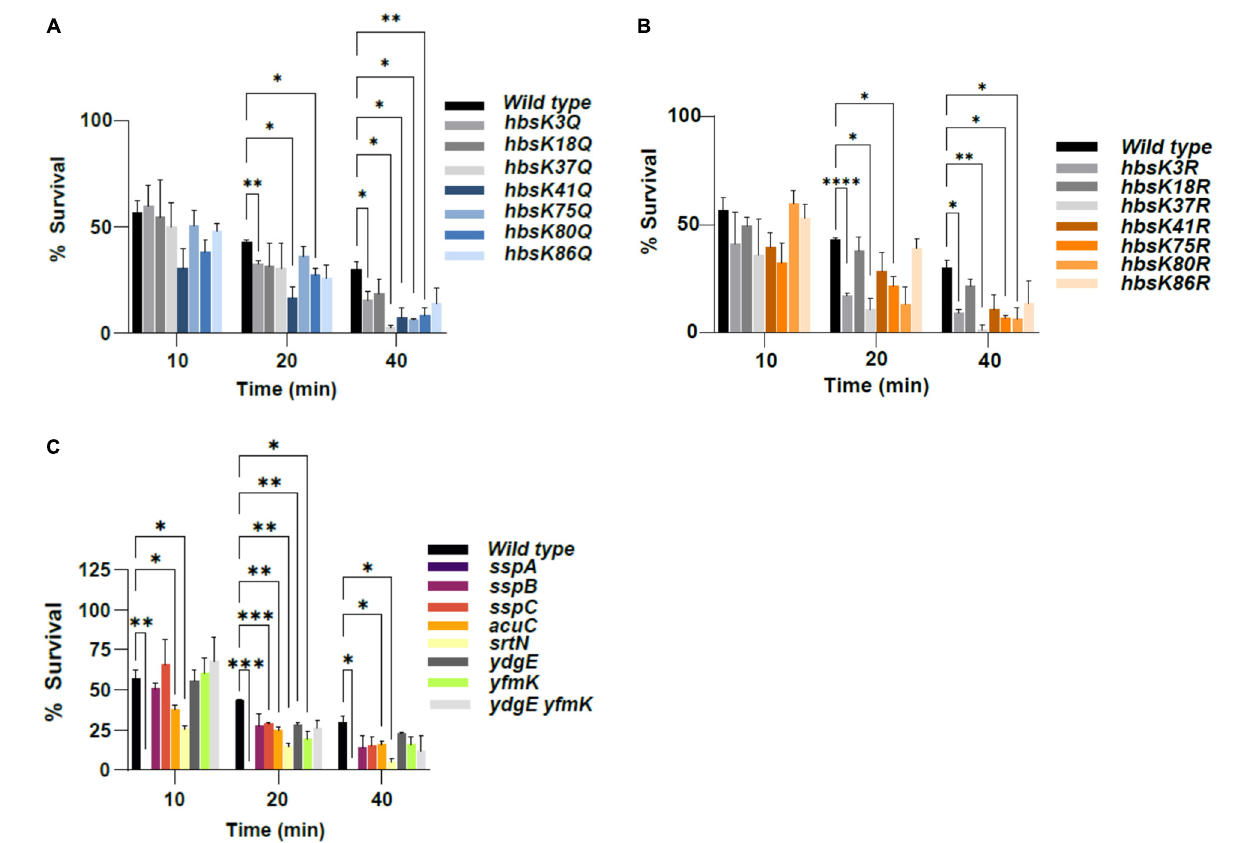
FIGURE 3 | The effects of acetylation on formaldehyde resistance. B. subtilis spores were isolated following growth in sporulation media for 48 h. Spores were diluted and subsequently exposed to 2.5% formaldehyde for a total of 40 min. At 10, 20, and 40 min, spores were plated for viable counts, and the survival percentage was calculated as formaldehyde-resistant colony forming units (CFUs)/ml divided by total viable counts (CFU/ml), pre-treatment. Bar graphs represent the average percentages determined from at least three independent replicates with error bars representing standard deviations. All time points were normalized to the zero time point for each strain (not displayed), which was set at 100%. The strains used in panels (A–C) were as described in the legend for Figure 1 . Statistical analyses were performed using GraphPad Prism 9. Two-factor ANOVAs with repeated measures, and a post hoc Dunnett square analysis were used to determine statistical significance. A p -value of ≤ 0.05 was considered significant. ∗ p < 0.05, ∗∗ p < 0.01, ∗∗∗ p < 0.001, ∗∗∗∗ p <